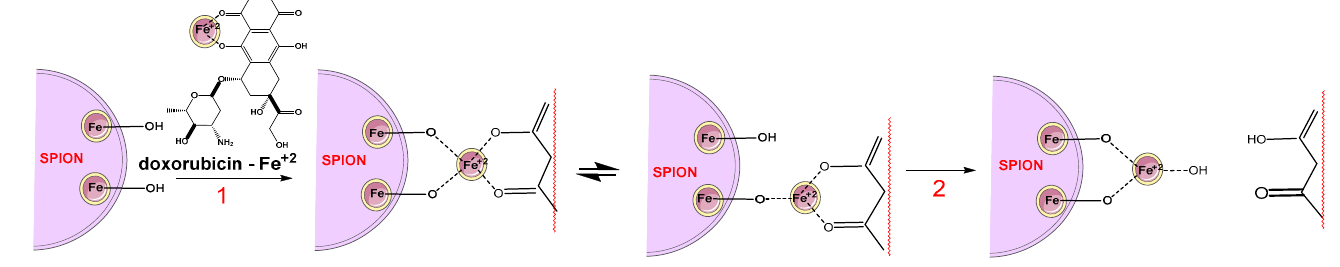
Figure 9. DSPION nanoparticles with dextran and doxorubicin: (1)—DOX-Fe 2+ loading; (2)—DOX releasing. Adapted from [158], Elsevier, 2008.